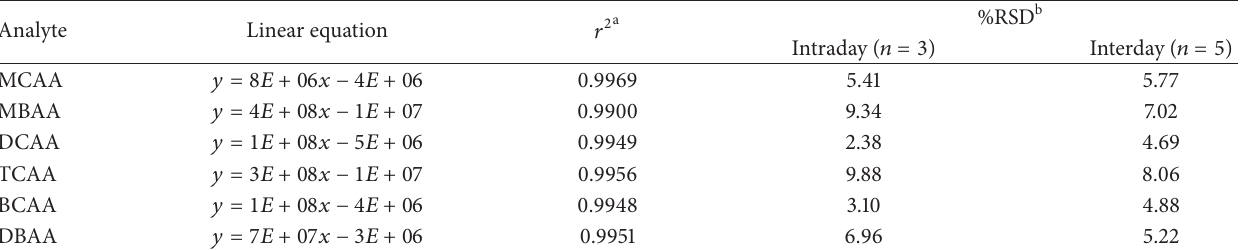
Table 1: Calibration data and repeatability of the proposed method.